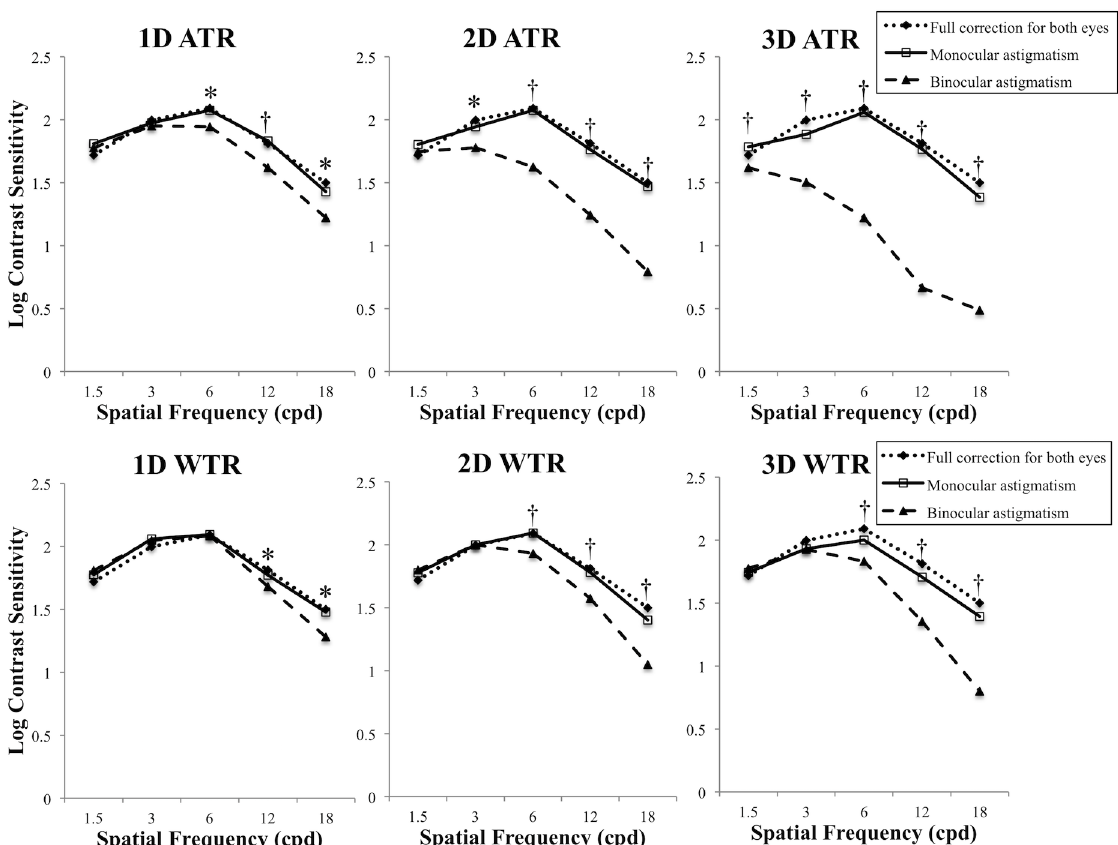
Fig 4. Comparison of log contrast sensitivity (CS) between binocular and monocular astigmatic defocus in each spatial frequency. When we compared log CS in each spatial frequency, CS under binocular conditions was significantly worse than that under monocular conditions at higher spatial frequencies (especially at 12 and 18 cpd) regardless of astigmatic power. ( (cid:3) P < 0.05; †P < 0.01, Wilcoxon signed- ranks test) (ATR = against-the-rule, WTR =